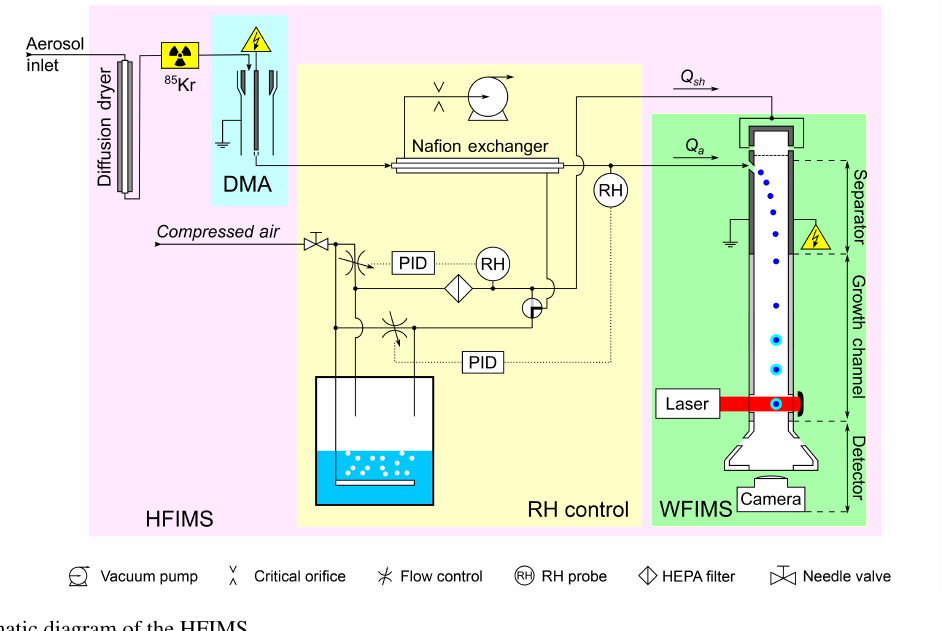
Figure 1. Schematic diagram of the HFIMS.